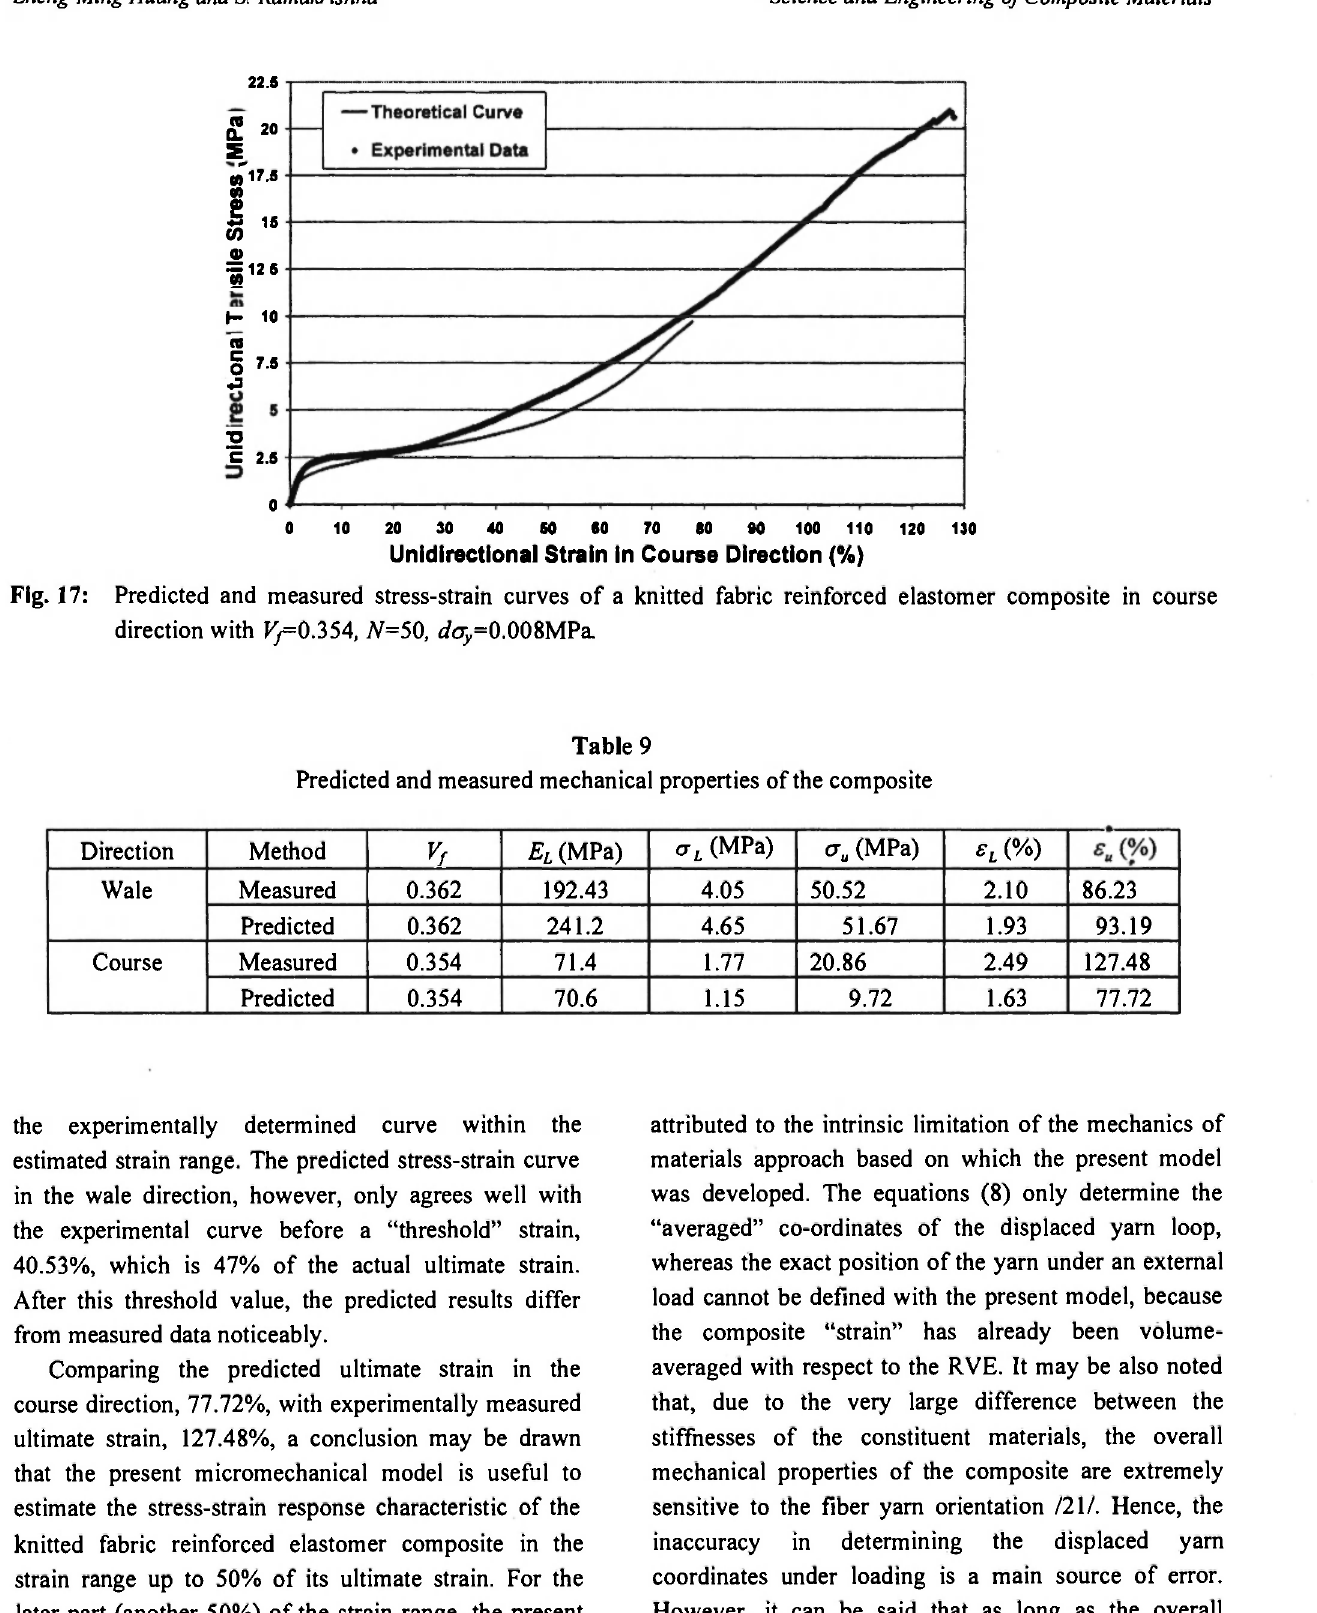
Fig. 17: Predicted and measured stress-strain curves of a knitted fabric reinforced elastomer composite in course direction with Vf= 0.354, j V=50, i/^=0.008MPa.